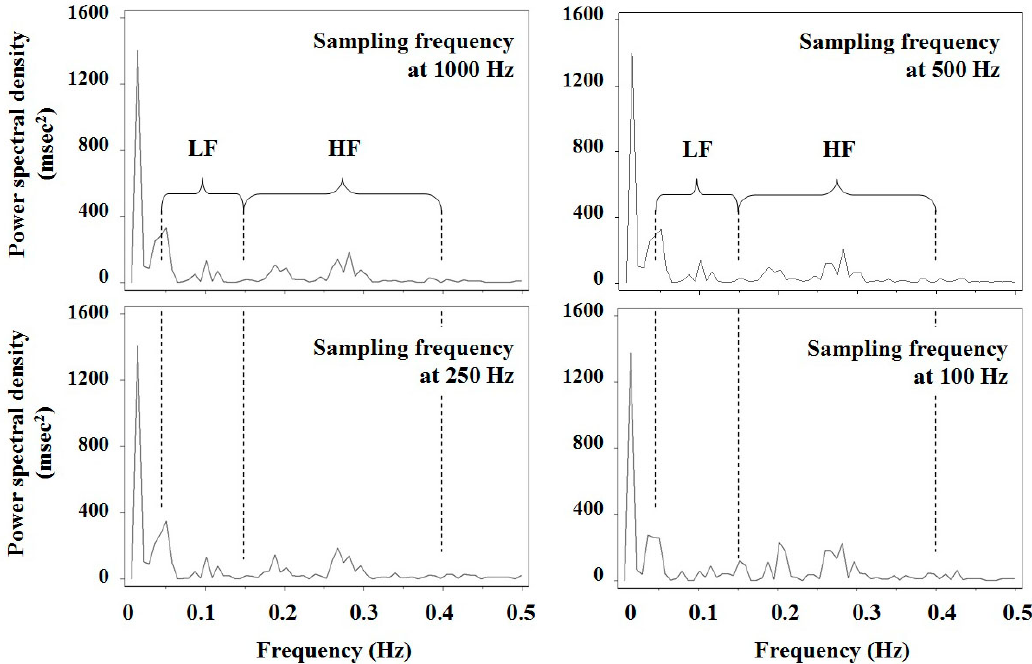
Figure 2. Results of spectral analysis of 128 consecutive R ‒ R intervals using a fast Fourier transform in a male student. The original R ‒ R intervals were measured at the sampling frequency of 1000 Hz after a subject rested in the supine position for 10 min, and data for lower sampling frequencies (500 Hz, 250 Hz and 100 Hz) were generated from the original data taking into account random error. LF and HF represent low frequency and high frequency bands, respectively.